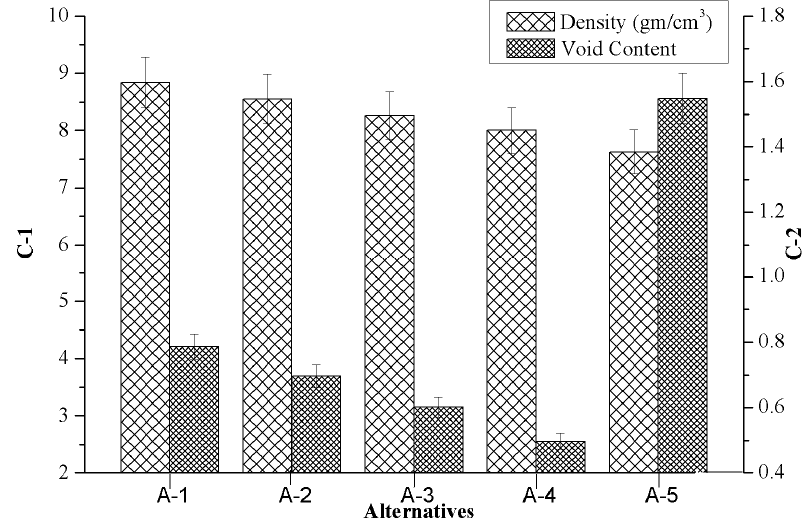
Figure 3. Variation of criterion-1 together with criterion-2 in respect to the values of alternatives .